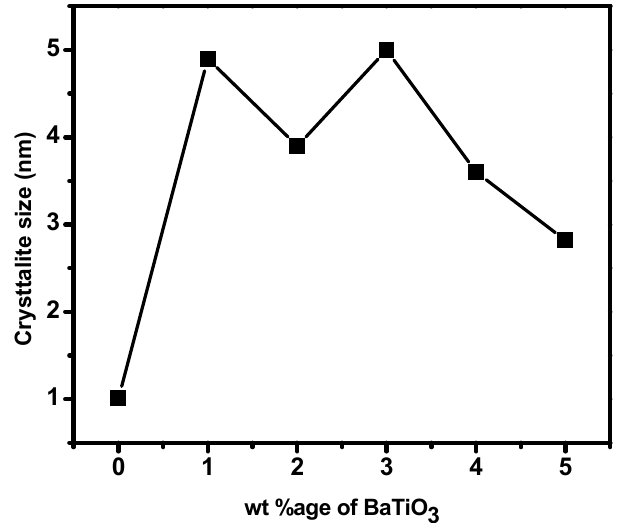
Figure 10. Crystallite size as a function of wt % BaTiO 3 in the composites.